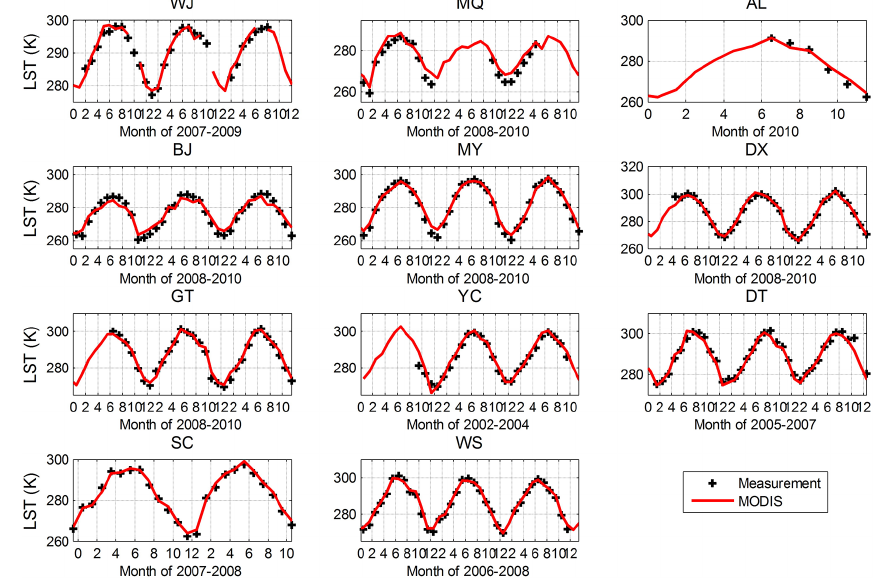
Figure 2. Time-series comparison of monthly averaged LST derived from MOD11C3, MYD11C3 and in situ measurements.